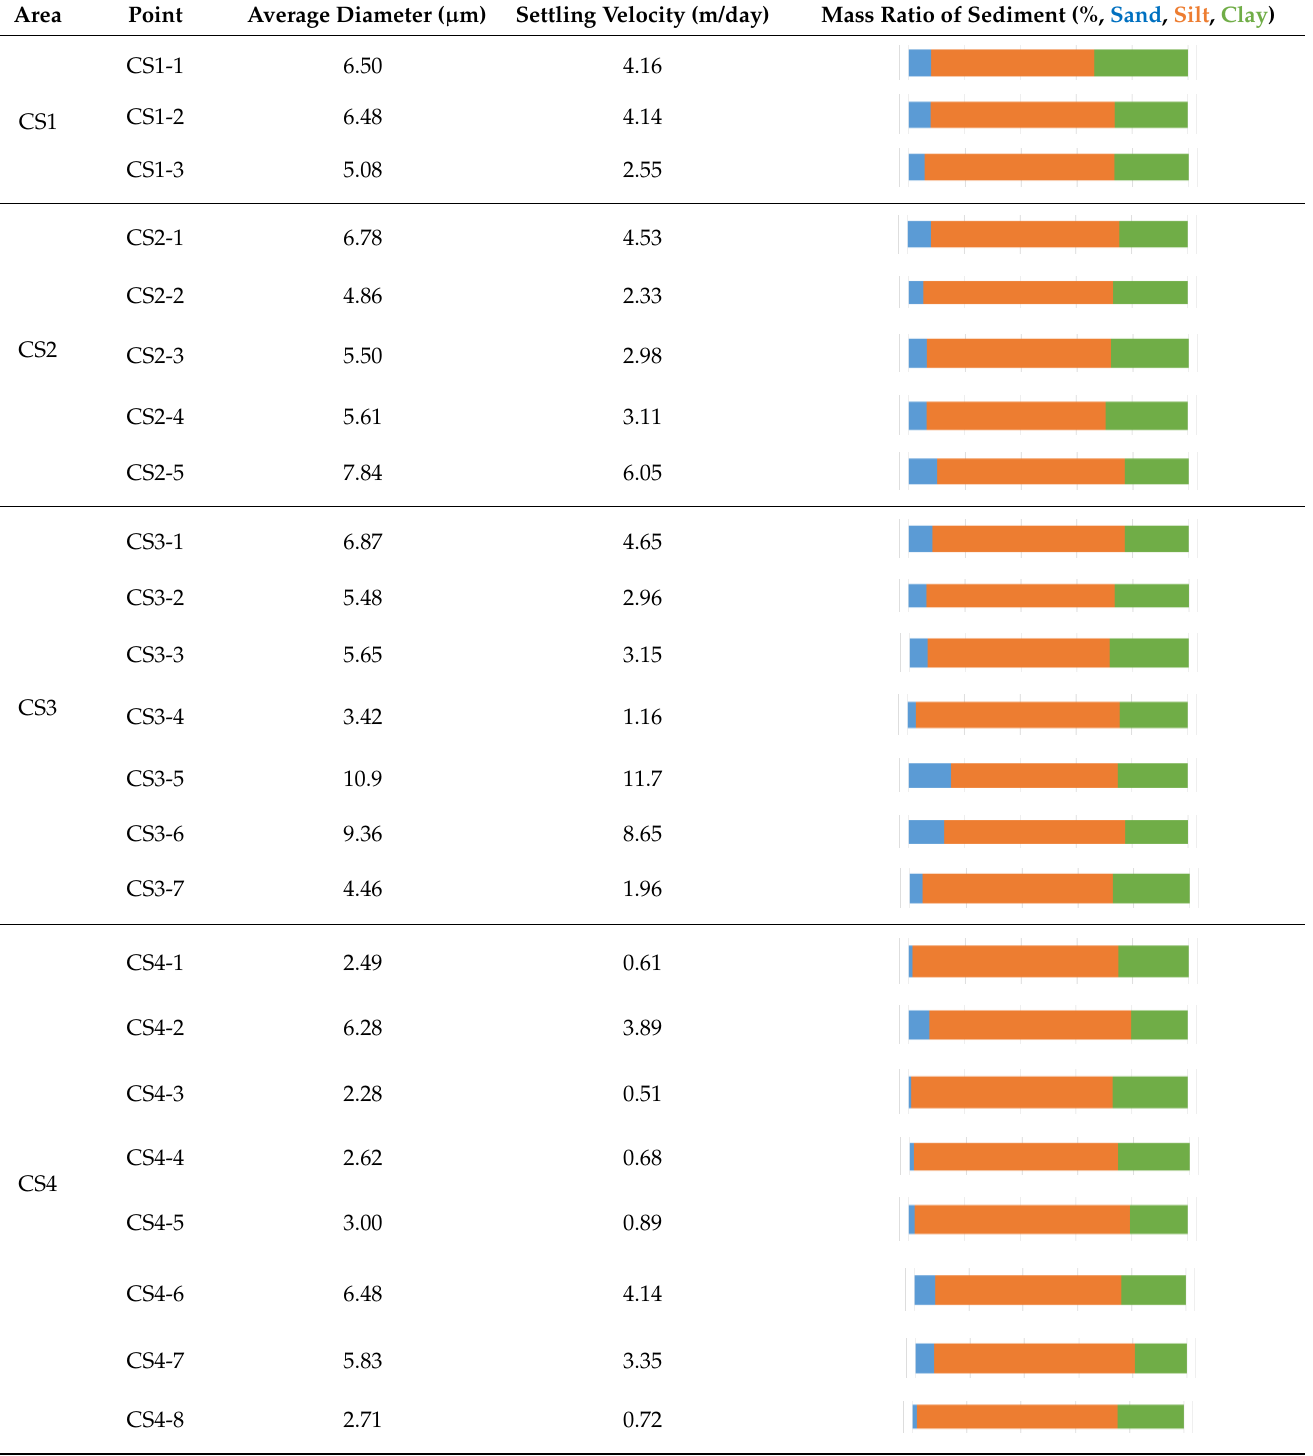
Table 3. Sediment characteristics across various cross sections (CS) in Tonle Sap Lake, Cambodia.